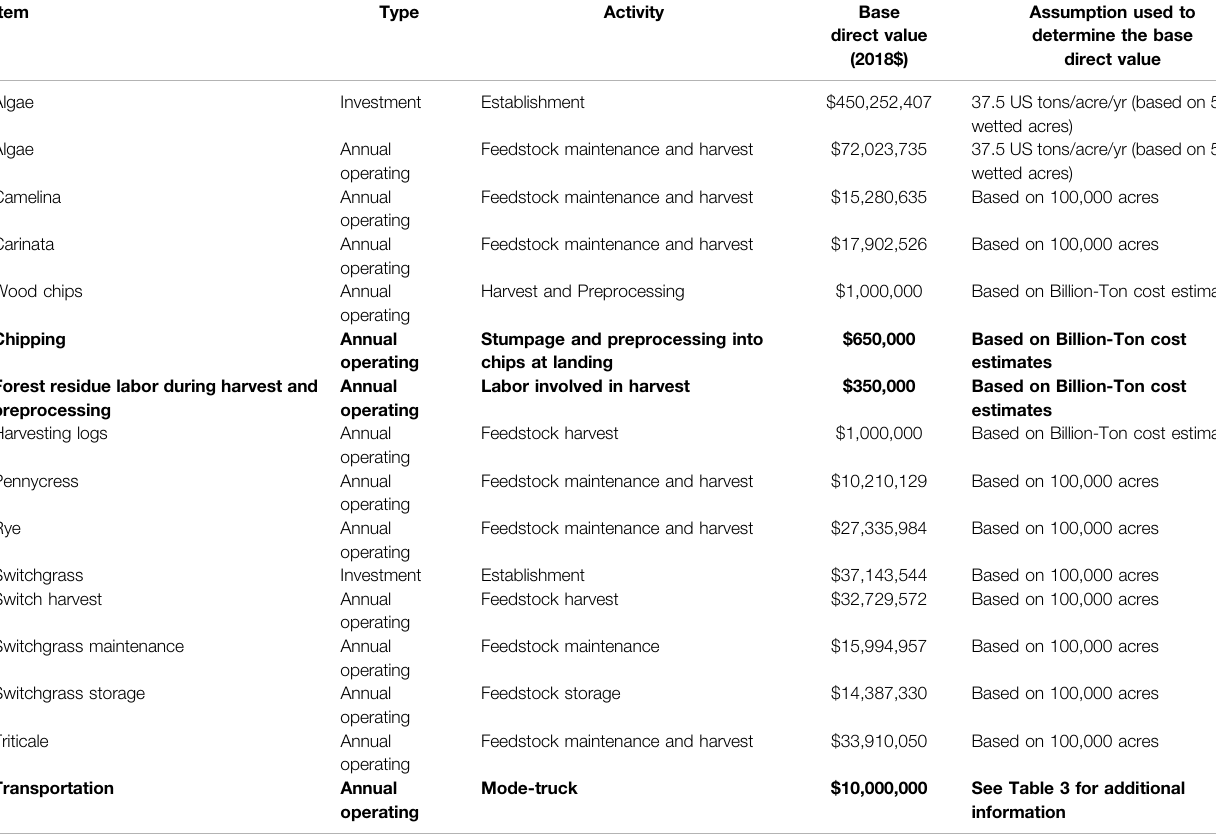
TABLE 2 | Summary of the basic costs of feedstock